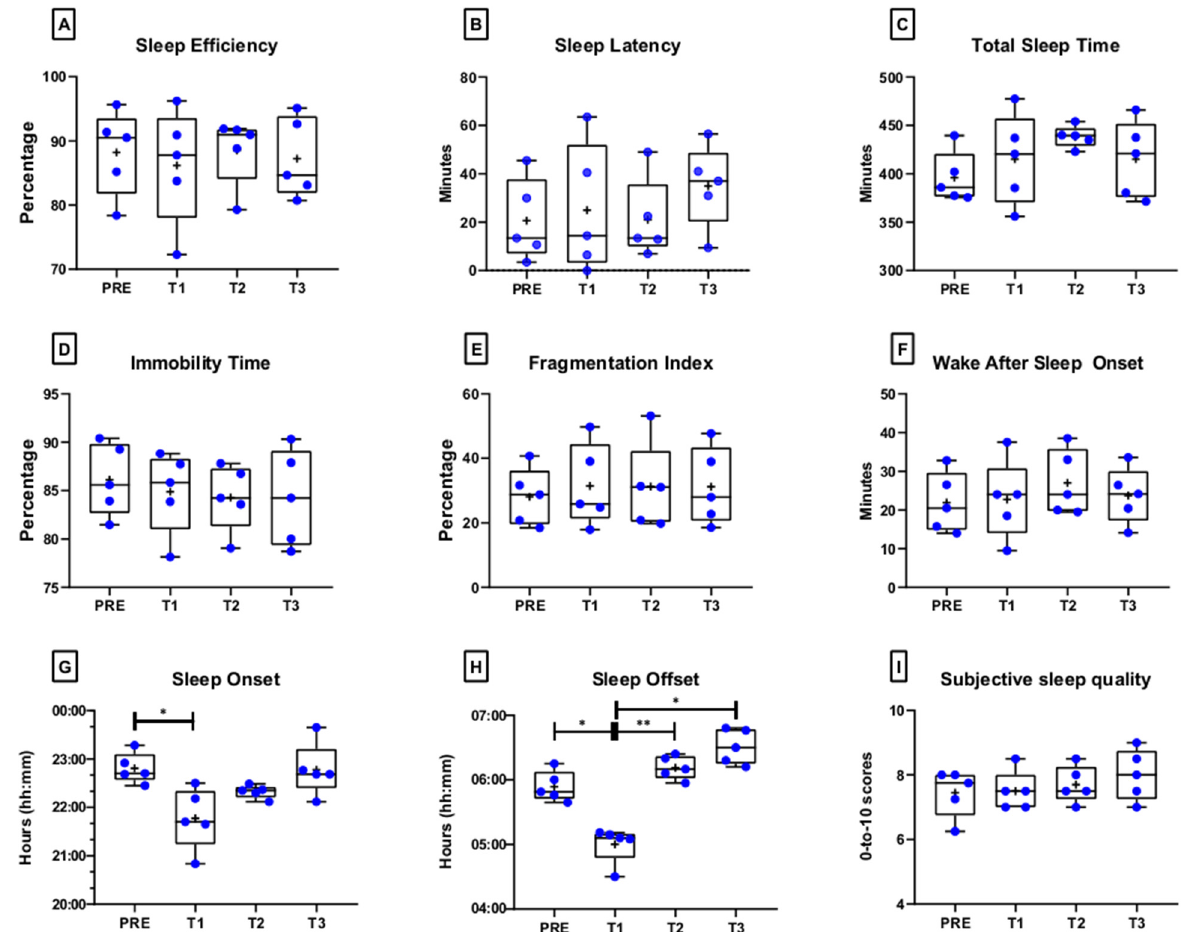
Figure 1. Whisker plot with single data (blue circles) of median, first, and third quartiles and minimum and maximum values of actigraphy-based (panels A – H ) and subjective (panel I ) sleep parameters before ATC (PRE), the first two days of ATC (T1), and after one week (T2) and two weeks of ATC (T3). *: p < 0.05; **: p < 0.01.